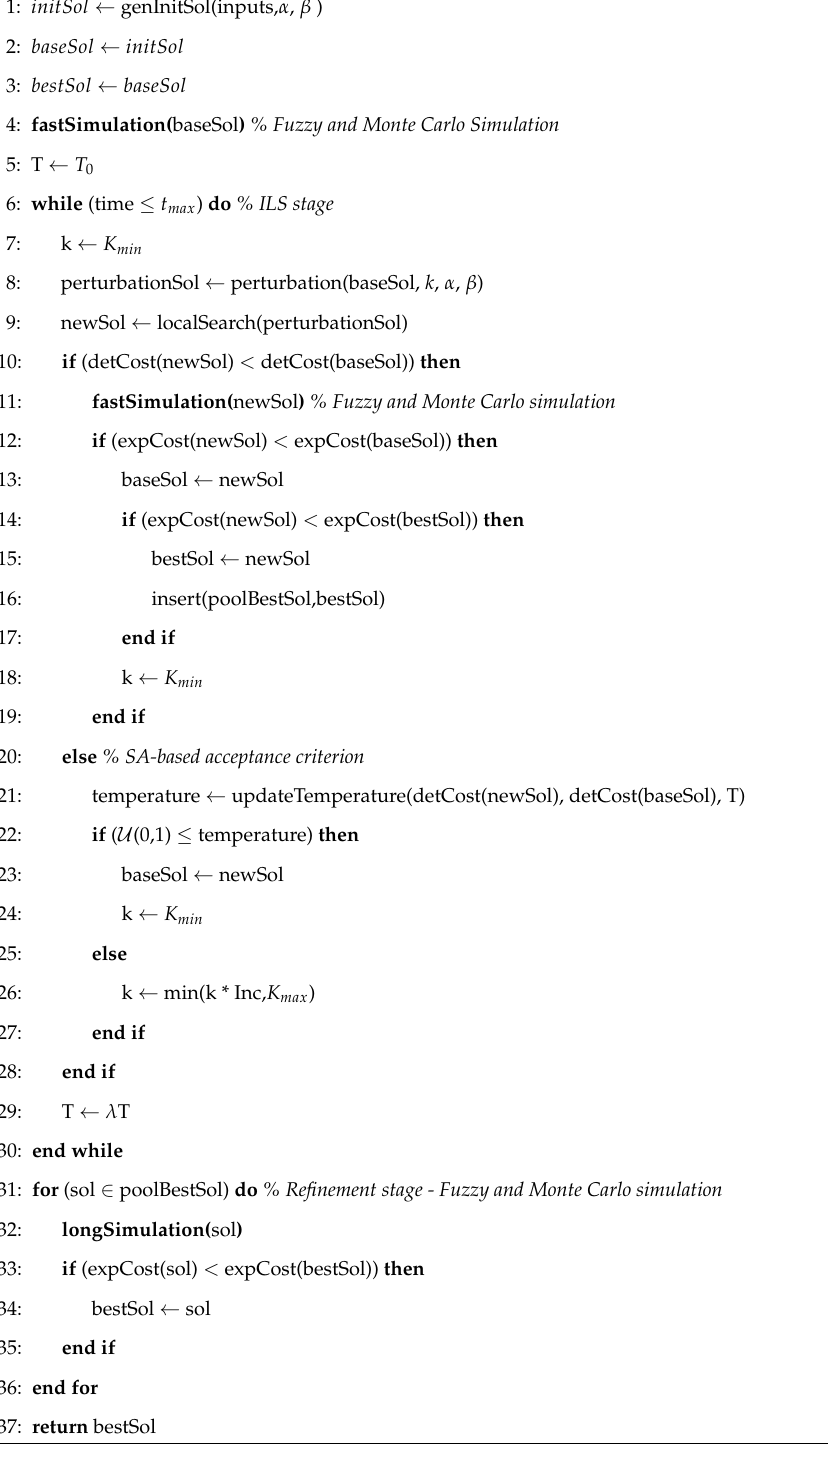
Algorithm 2 ILS-based Fuzzy Simheuristic ( inputs , α , β , λ , Inc , T 0 , K min , K max , I 0 , t max